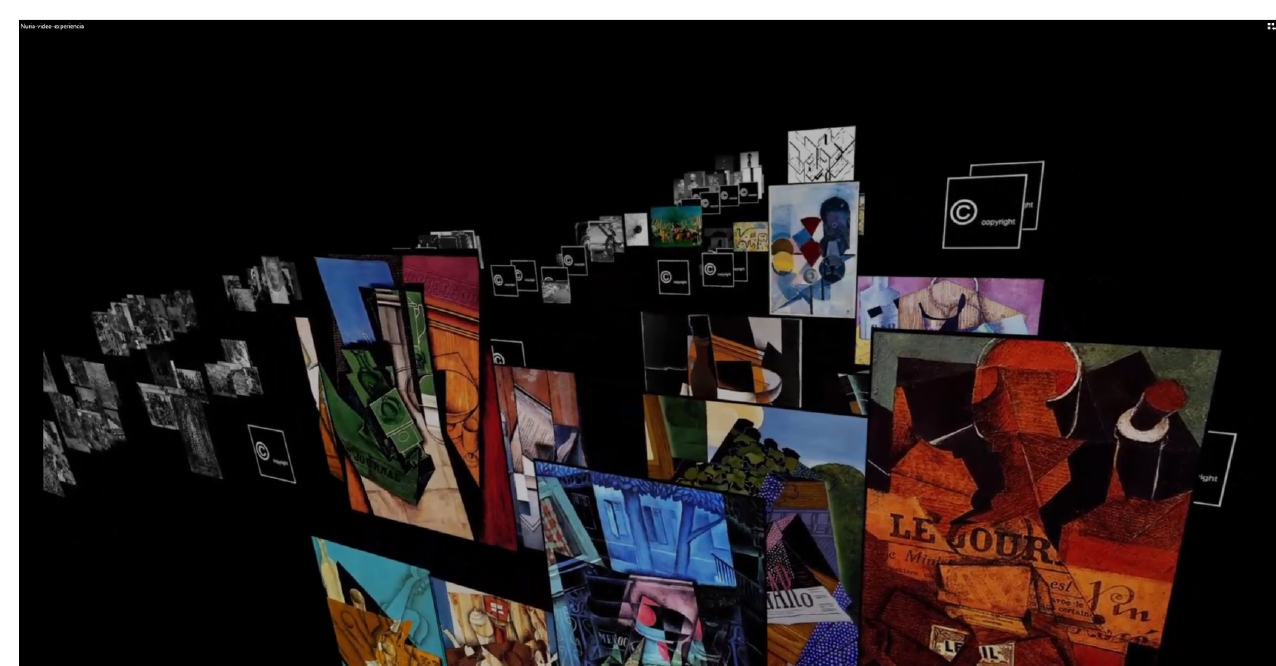
Figure 8. Image high-dimensional vector space rebuilt as immersive three-dimensional space. Post- catálogo Project. Available on: https://poscatalogo.iarthislab.eu/ (accessed on 28 July 2022) (screen- shot).